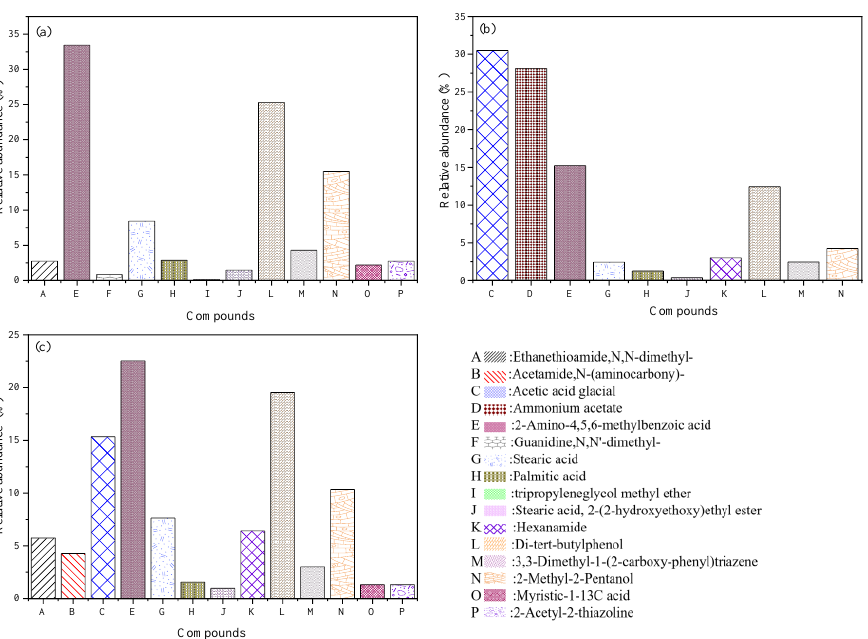
Figure 4. Types and relative abundance of pollutants in different water samples: ( a ) Wastewater; ( b ) Fenton oxidation; ( c ) Ozone oxidation. Table 2. GC – MS analysis of petrochemical wastewater.